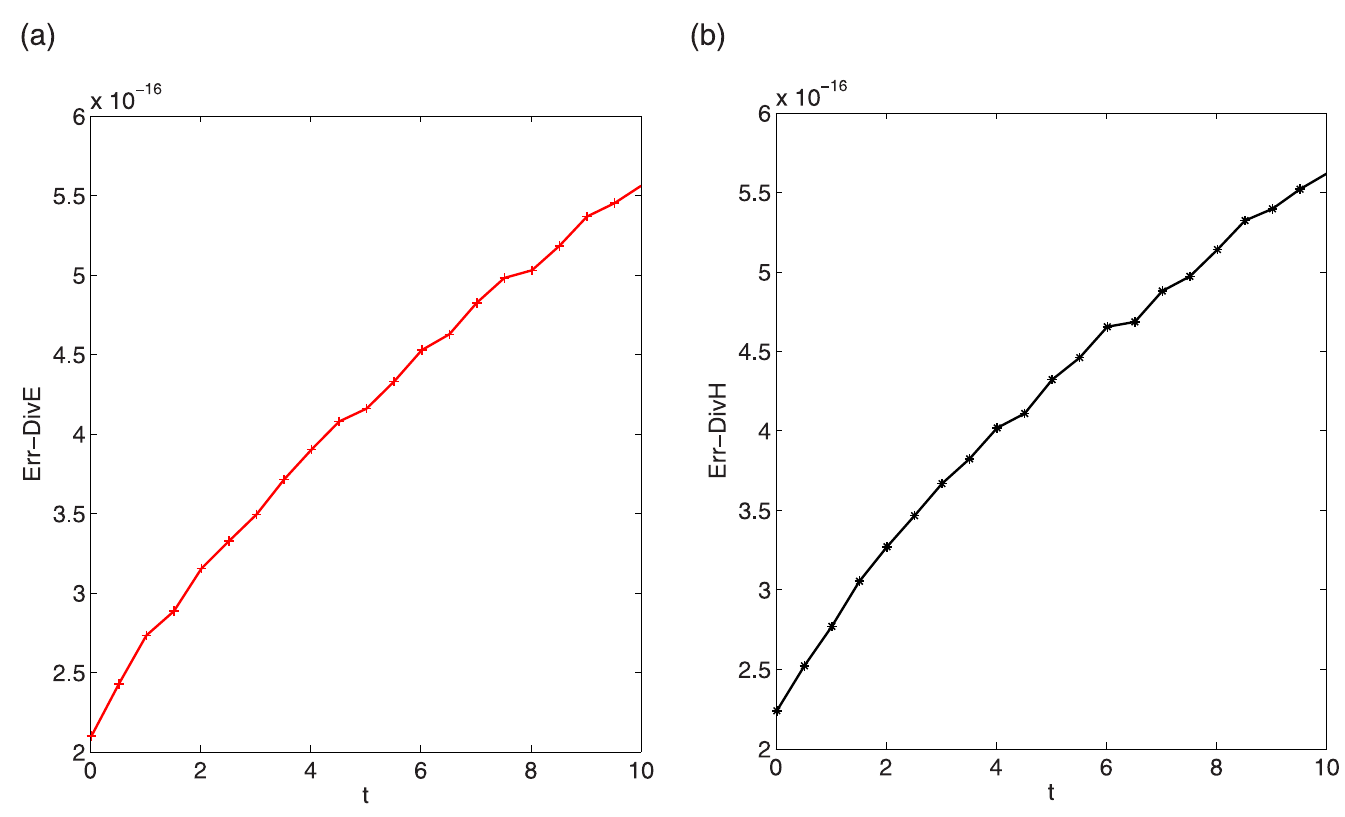
Fig 16. Divergence errors Err-DivE (left) and Err-DivH (right) in second testing case.